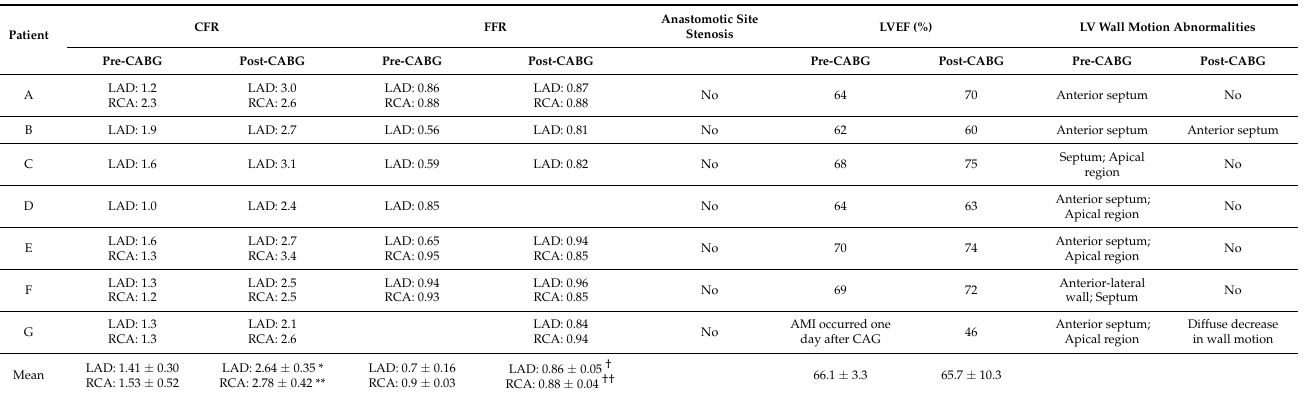
Table 2. Comparison of CFR, FFR, LVEF, and LV wall motion before and after CABG and the presence or absence of bypass anastomotic